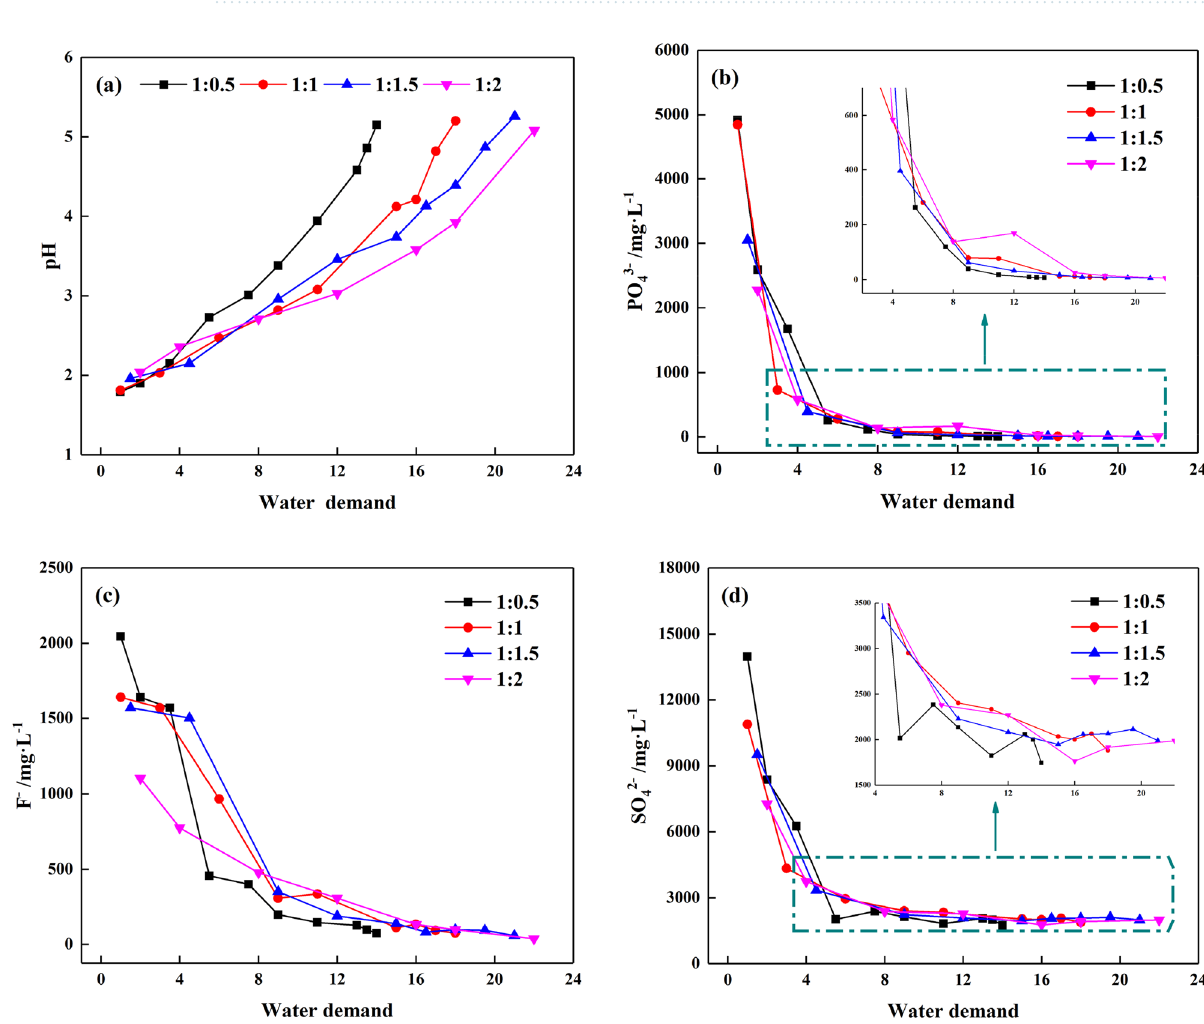
Figure 3. Variations of PG with different S/L ratio: ( a ) pH, ( b ) PO 43− , ( c ) F − , ( d ) SO 42−